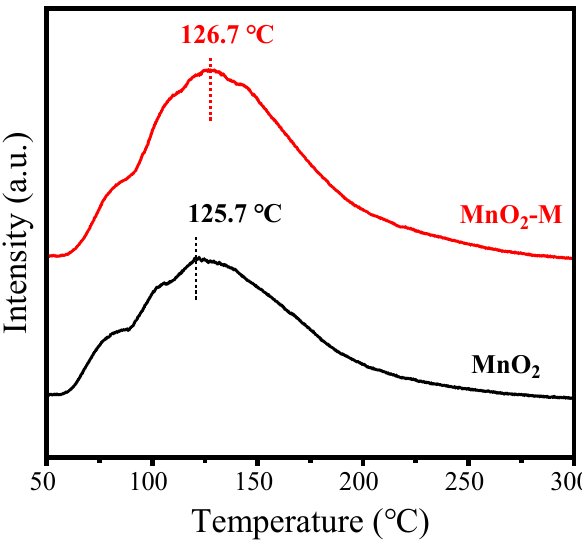
Figure 6. NH 3 -TPD curves of the catalysts. Table 4. Quantitative analysis of NH 3 -TPD over the catalysts.